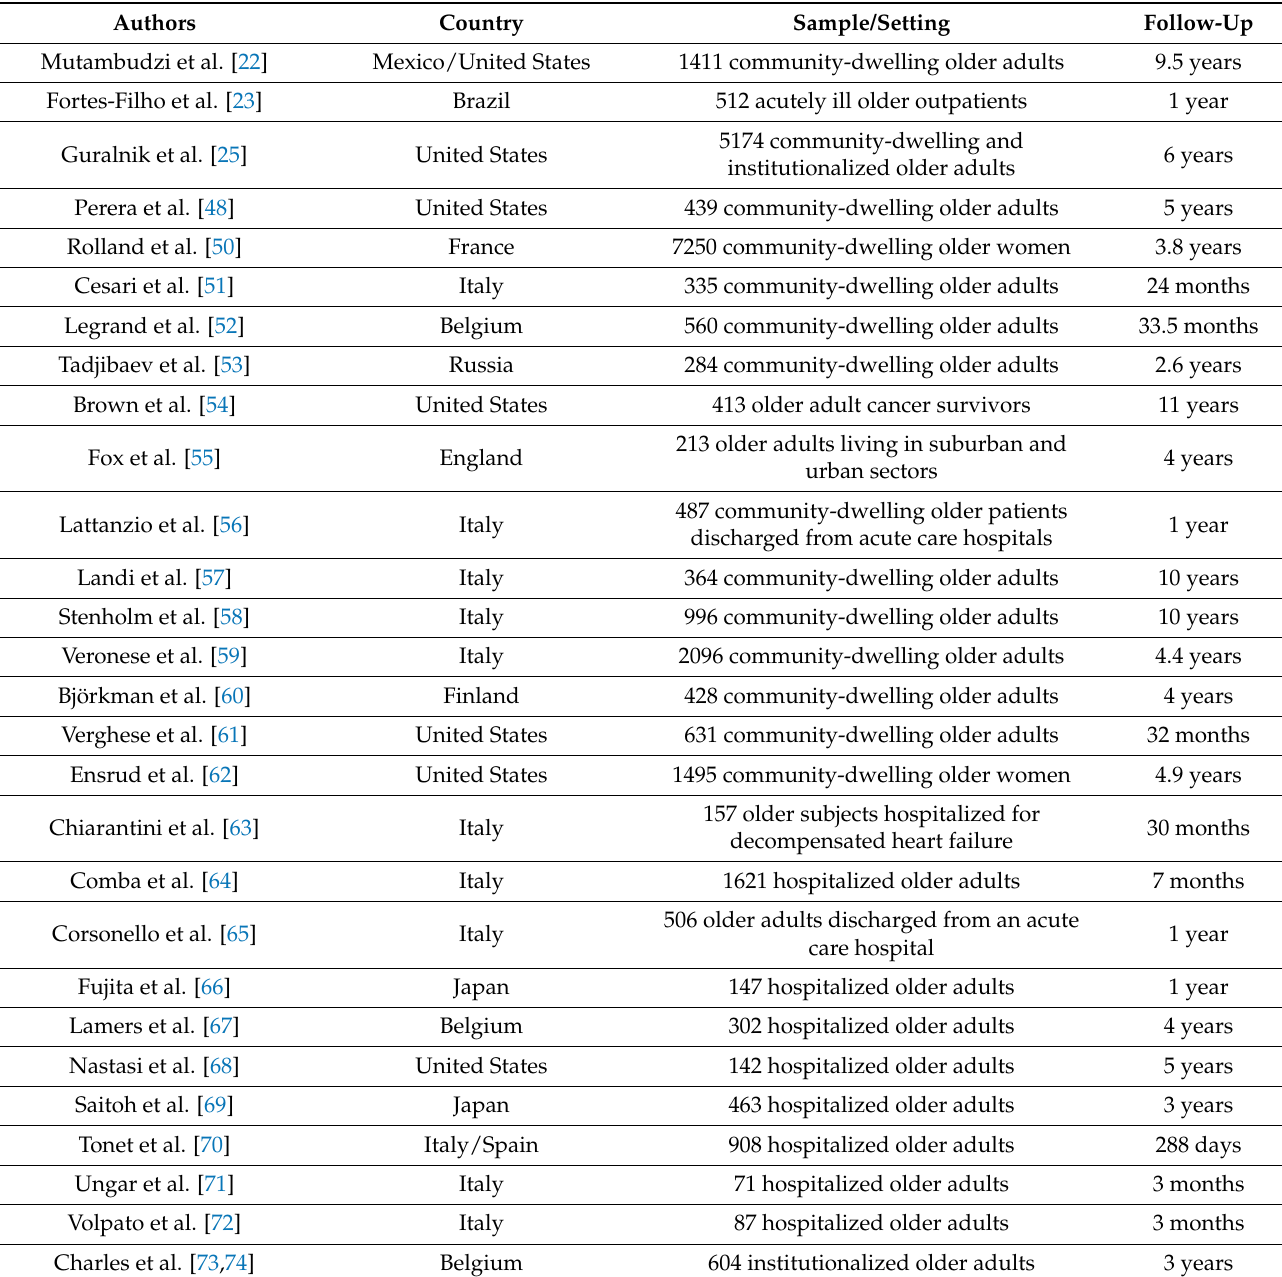
Table 1. Characteristics of longitudinal studies conducted with older adults on the relationship between the SPPB and mortality ( n =